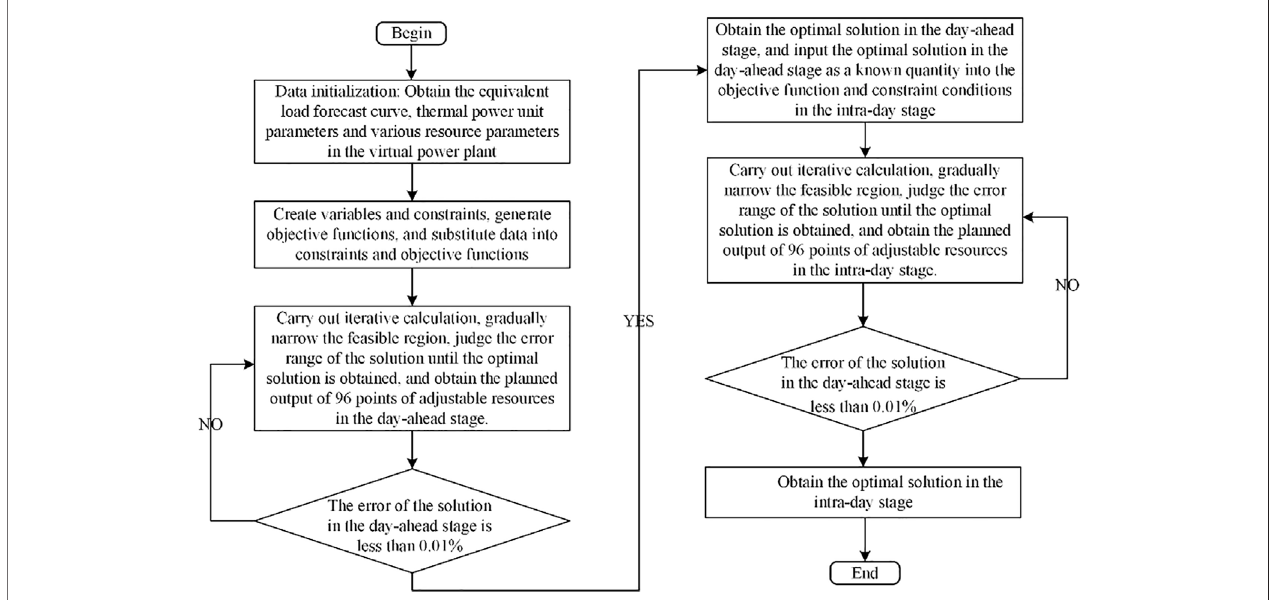
FIGURE 3 | Flowchart of branch and bound